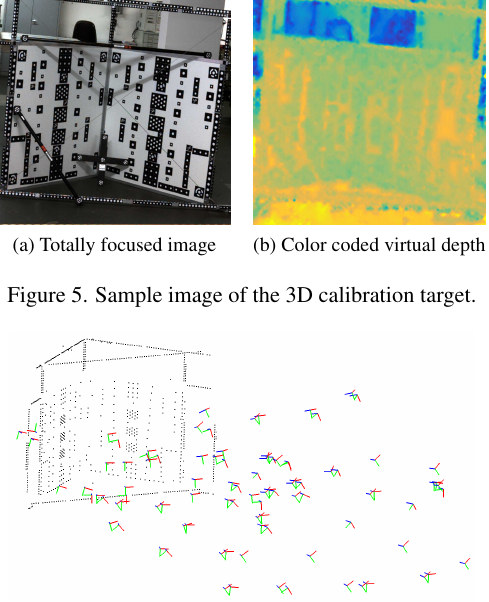
Figure 6. Calibration points and camera poses in 3D object